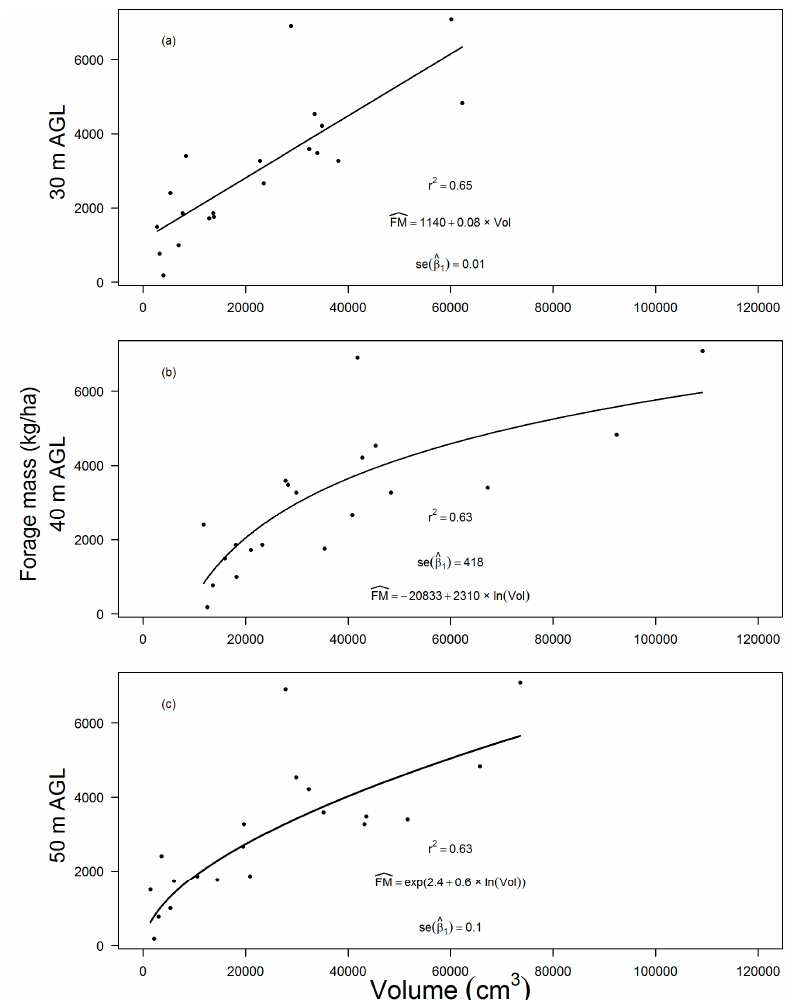
Figure 4. Regression analysis between forage mass and 3D model volumes from imagery obtained at Duval County Ranch in Duval County, TX, 31 August 2018. Coe ffi cient of determination (r 2 ) and standing forage crop production equation containing estimated regression coe ffi cients are shown for linear-linear regression analysis at 30 m AGL ( a ), linear-log regression at 40 m AGL ( b ), and log-log at 50 m AGL ( c ). AGL denotes height above ground